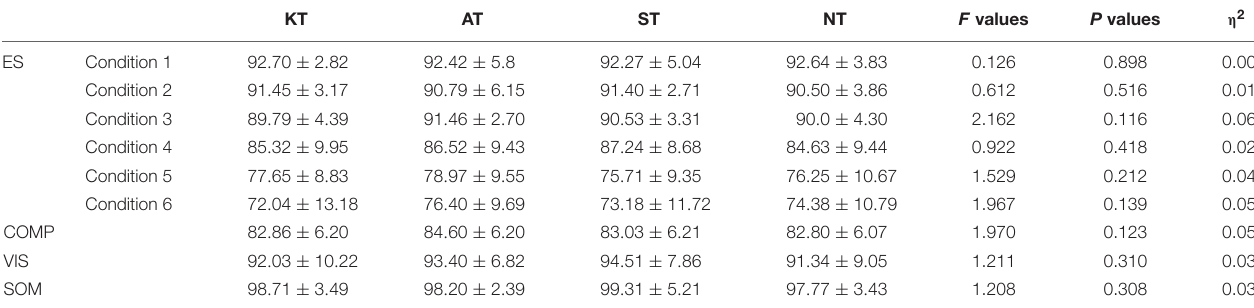
TABLE 2 | Comparison of equilibrium scores and composite scores in sensory organization test (SOT) for different taping treatments ( ¯ x ± s).